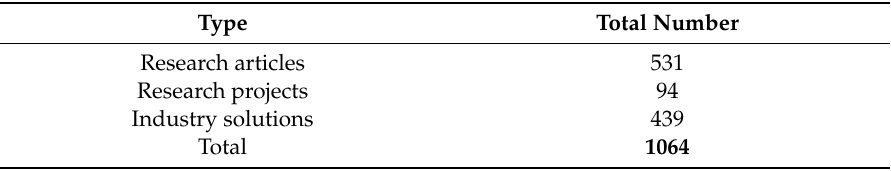
Table 3. Total number of smart farming technologies (SFTs) identified by the search conducted in available scientific papers, research projects and industrial products.